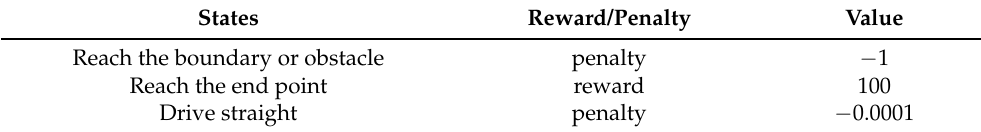
Figure 5. Comparison of planning effects of two algorithms. Table 1. Algorithm parameter